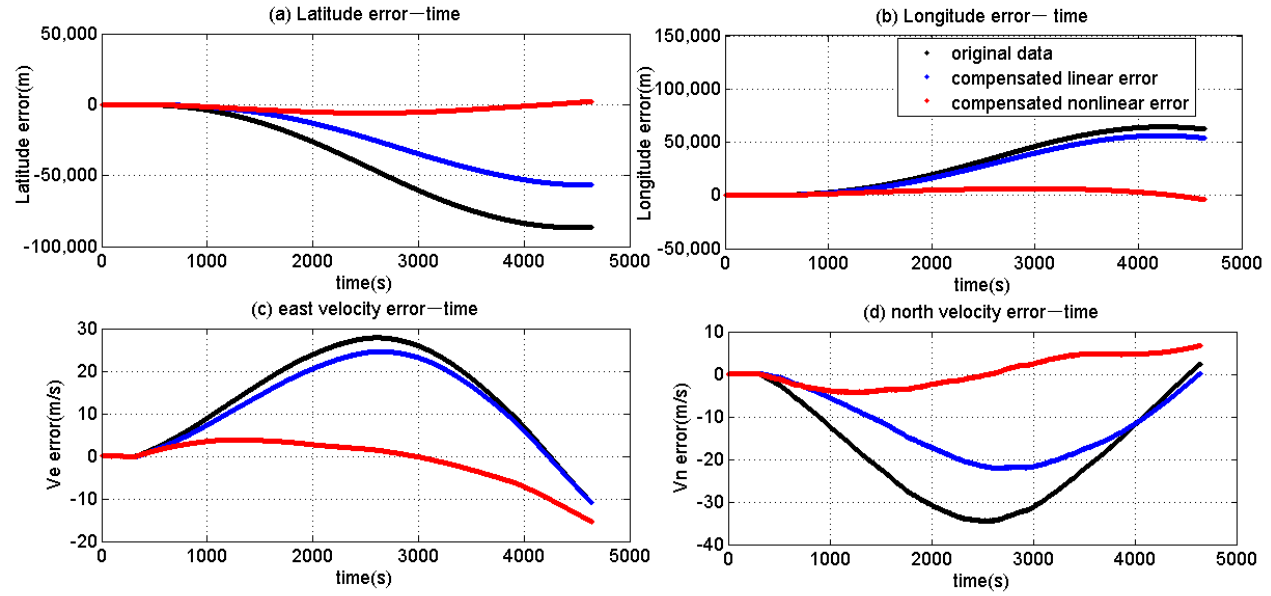
Figure 15. Position error and velocity error.